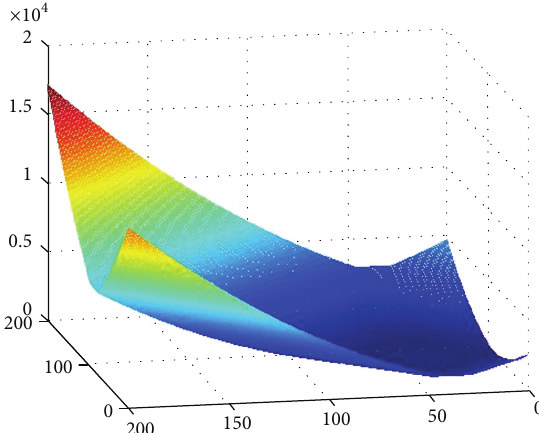
Figure 7: Resulting attractive potential field in the blocked corridor scenario.